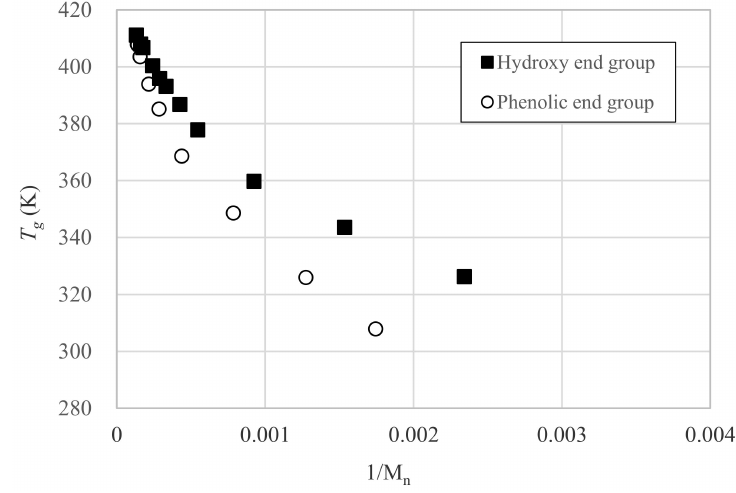
Figure 10. Relation between T g and 1 / M n